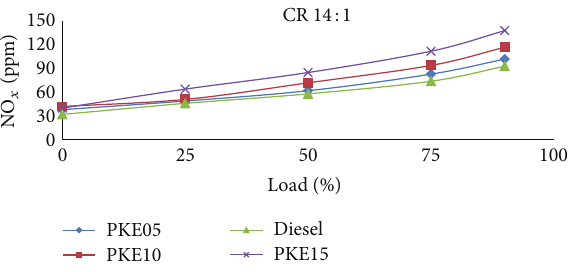
Figure 10: Load versus HC emissions at 14:1 CR.